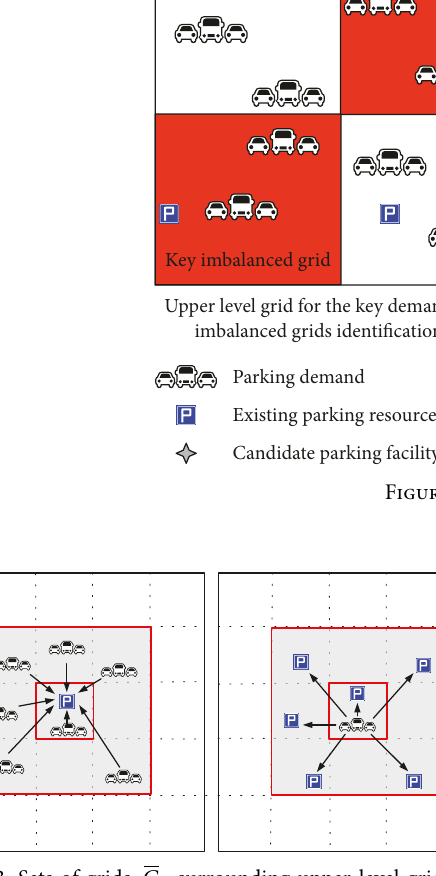
i , surrounding upper-level grid